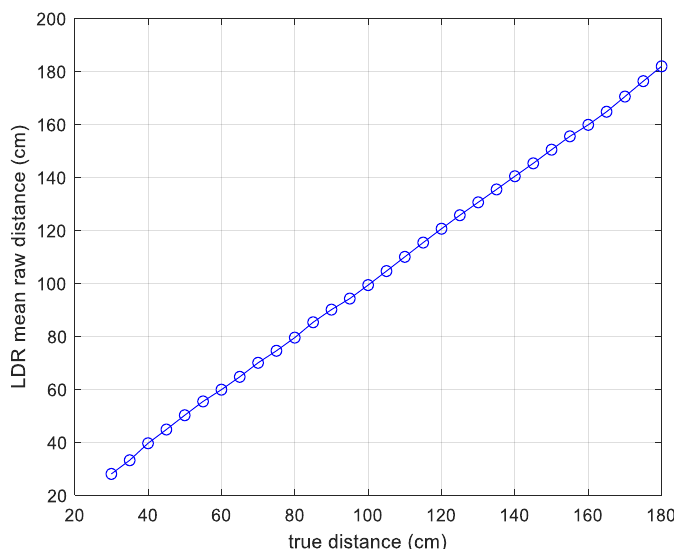
Figure 4. LiDAR distance measurements after bias removal. Each dot represents the average of 480 measurements at a sampling frequency of 4 Hz, i.e., 120-s acquisition time per distance value.